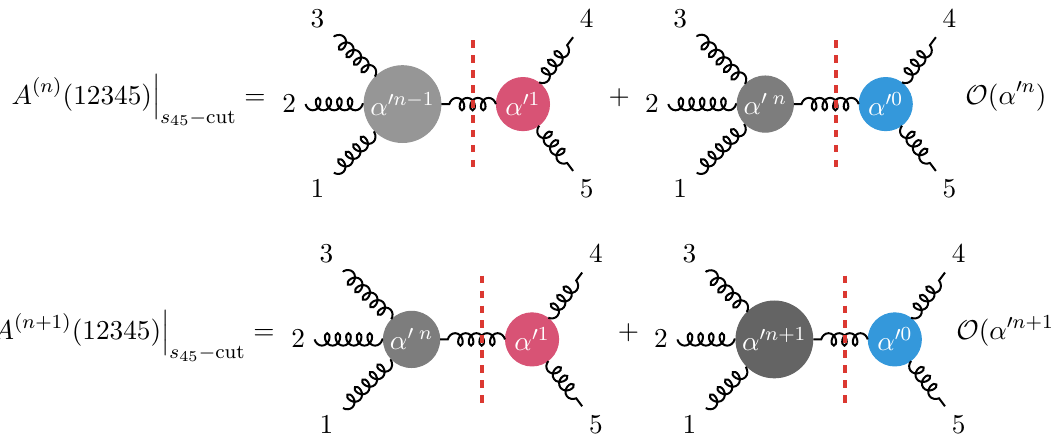
Figure 2 . Inductive ladder of higher-derivative contacts for the pure-vector theory generated by cuts of the form A ( k ) | cut ∼ ( A ( k ) A YM + A ( k − 1) A F 3 ) and considering double-copy consistency, where 3 3 5 4 4 A ( k ) n denotes n -point amplitudes appearing at mass-dimension α 0 k